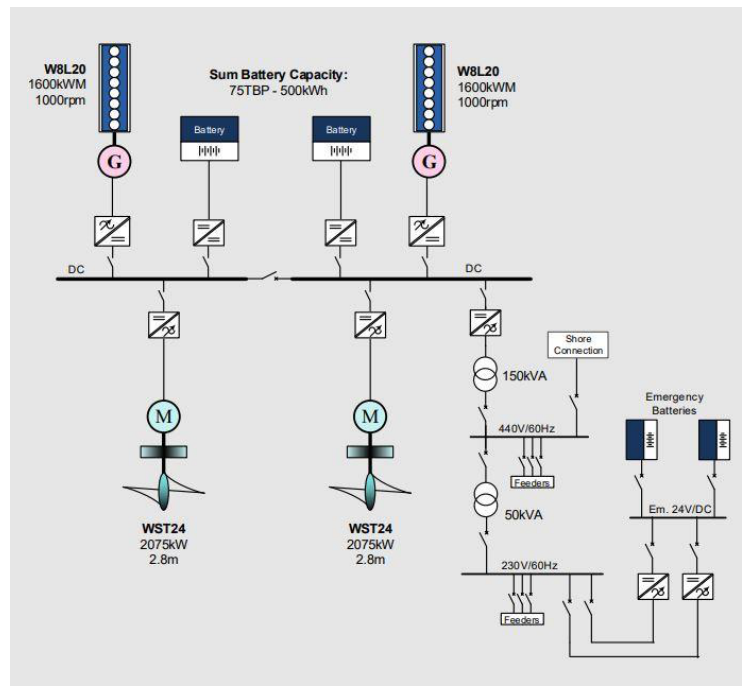
Figure 11. Single-line diagram of the diesel – electric hybrid system